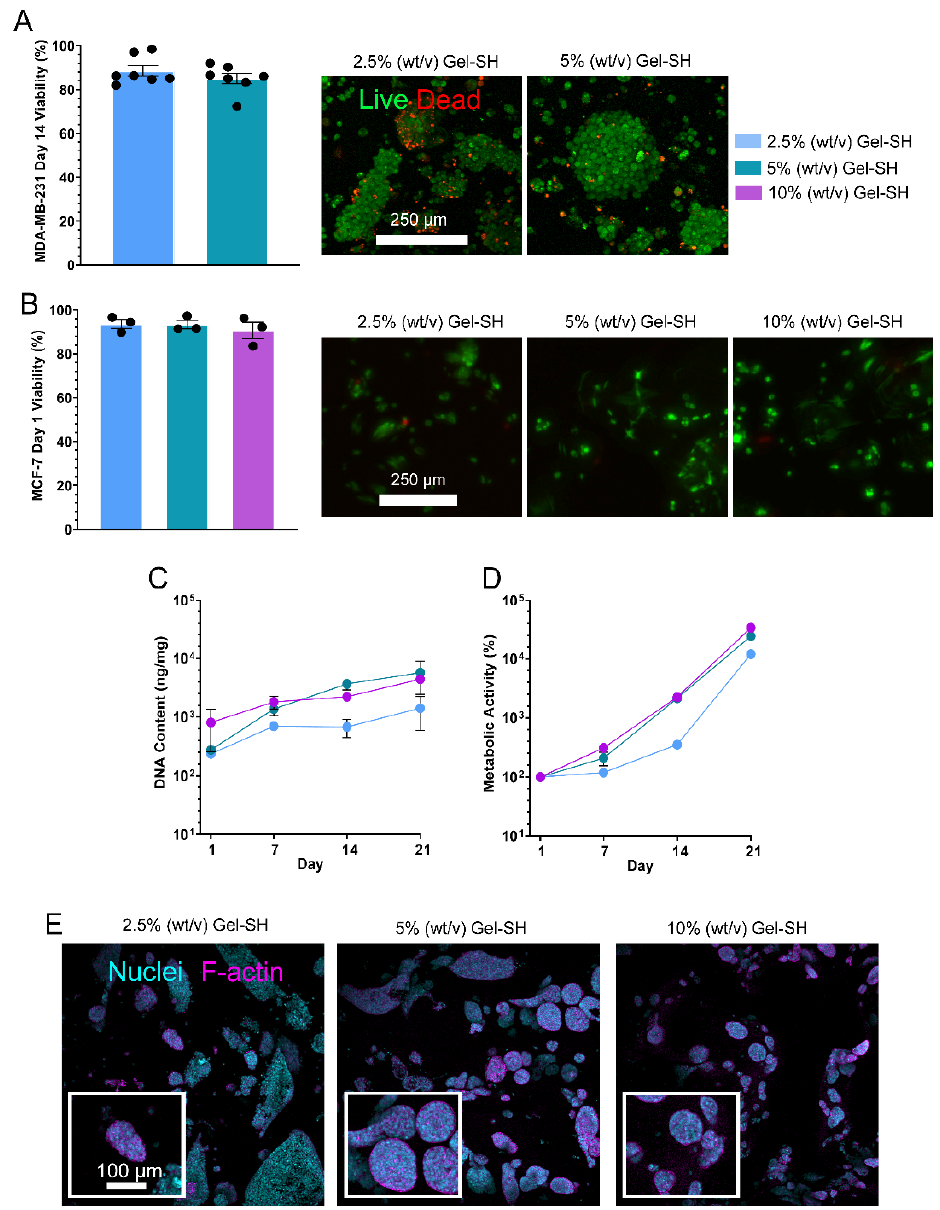
Figure 7. Growth of breast cancer cell lines in Gel-SH/PEG-4MAL hydrogels. ( A ) Day 14 vi- ability of MDA-MB-231 cells encapsulated in Gel-SH/PEG-4MAL hydrogels, via FDA/PI live (green)/dead (red) fluorescent staining and confocal imaging (maximum projections of Z-stacks shown). Scale = 250 µ m. ( n = 7; mean ± SEM); ( B ) Day 1 viability of MCF-7 cells encapsulated in Gel-SH/PEG-4MAL hydrogels. Scale = 250 µ m. ( n = 3; mean ± SEM). ( C ) DNA content of MCF-7- encapsulated Gel-SH/PEG-4MAL hydrogels normalized to the wet weight of the hydrogels ( n = 6; mean ± SEM); ( D ) Metabolic activity of MCF-7 cells encapsulated Gel-SH/PEG-4MAL hydrogels nor- malized to day 1 metabolic activity ( n = 6; mean ± SEM); ( E ) Confocal imaging of MCF-7-encapsulated Gel-SH/PEG-4MAL hydrogels (blue = nuclei, magenta = f-actin). Scale = 100 µ